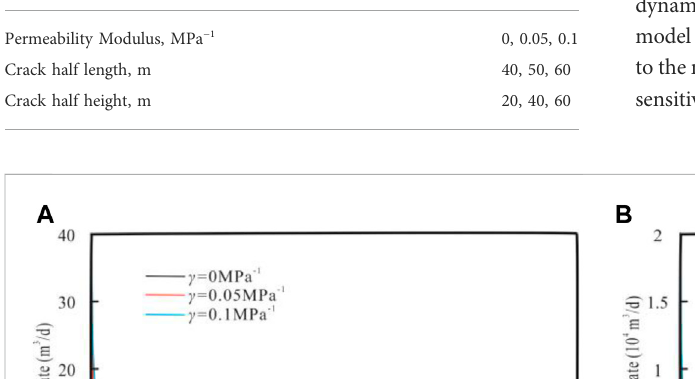
TABLE 2 Range of sensitivity